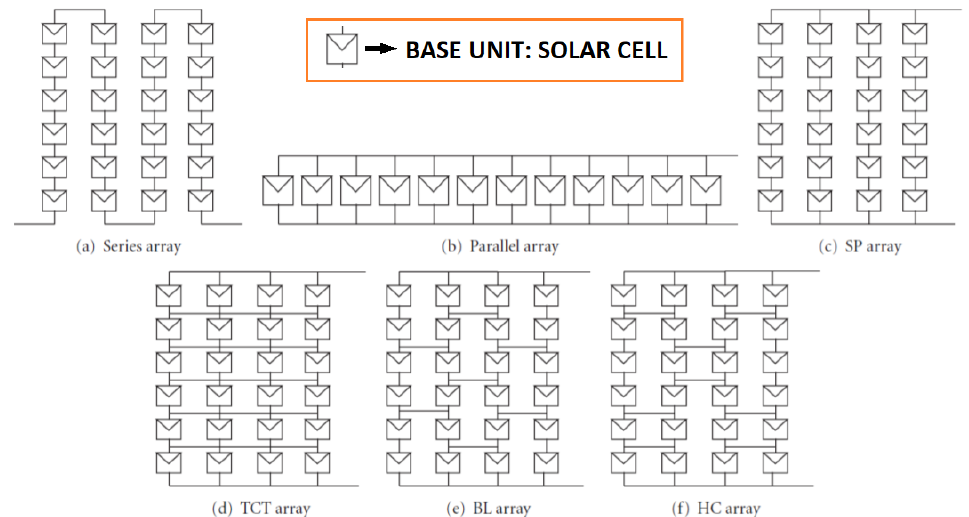
Figure 14. Different cells associations and modules configurations (adapted from [78]).